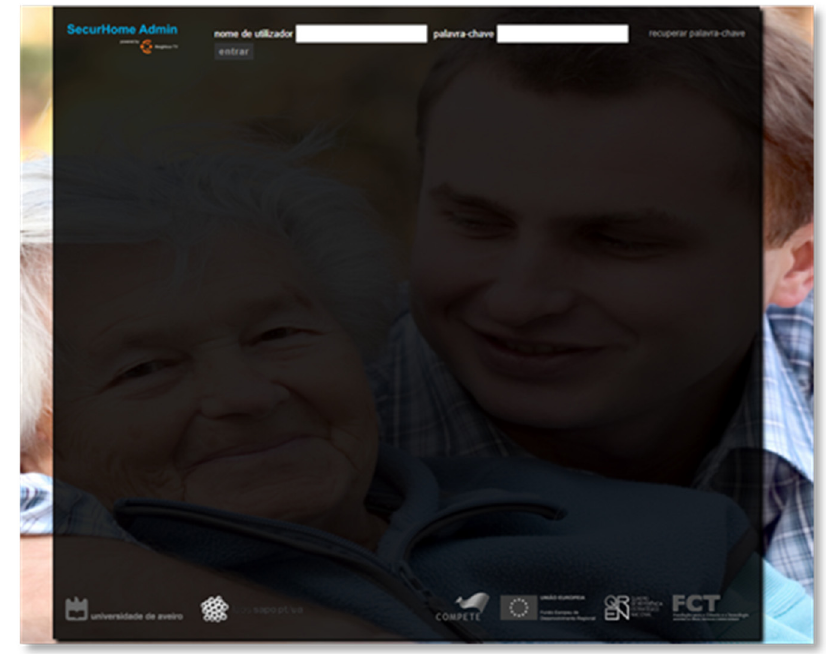
Figure 14. Login screen of the SecurHome Admin application.